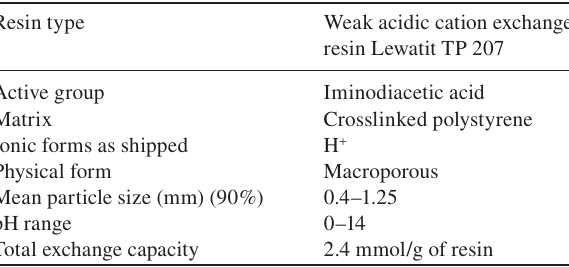
Table 1 Characteristic data of tested Lewatit TP